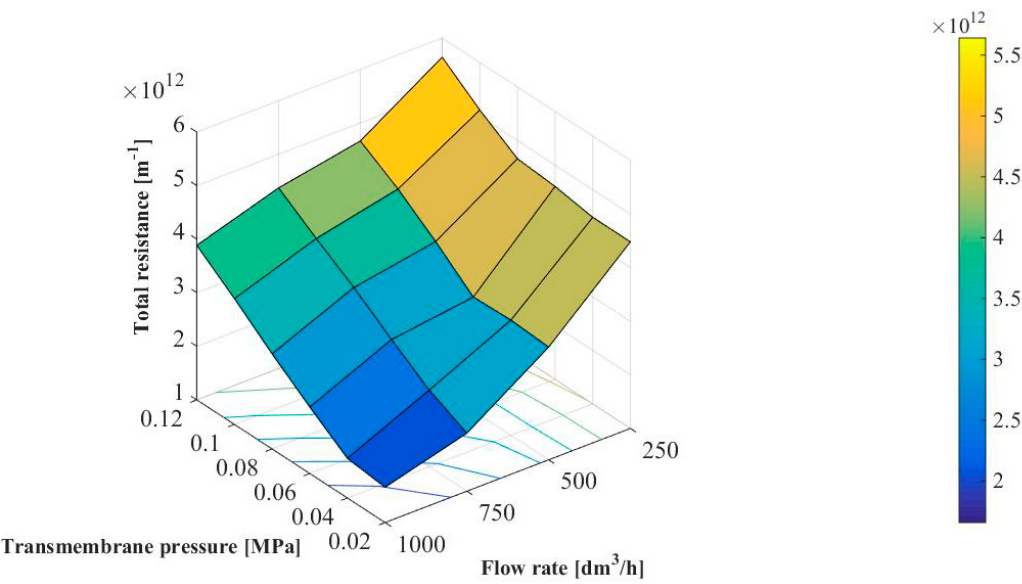
Figure 7. E ff ect of transmembrane pressure and feed flow rate on the total hydraulic Figure 7. Effect of transmembrane pressure and feed flow rate on the total hydraulic resistance.